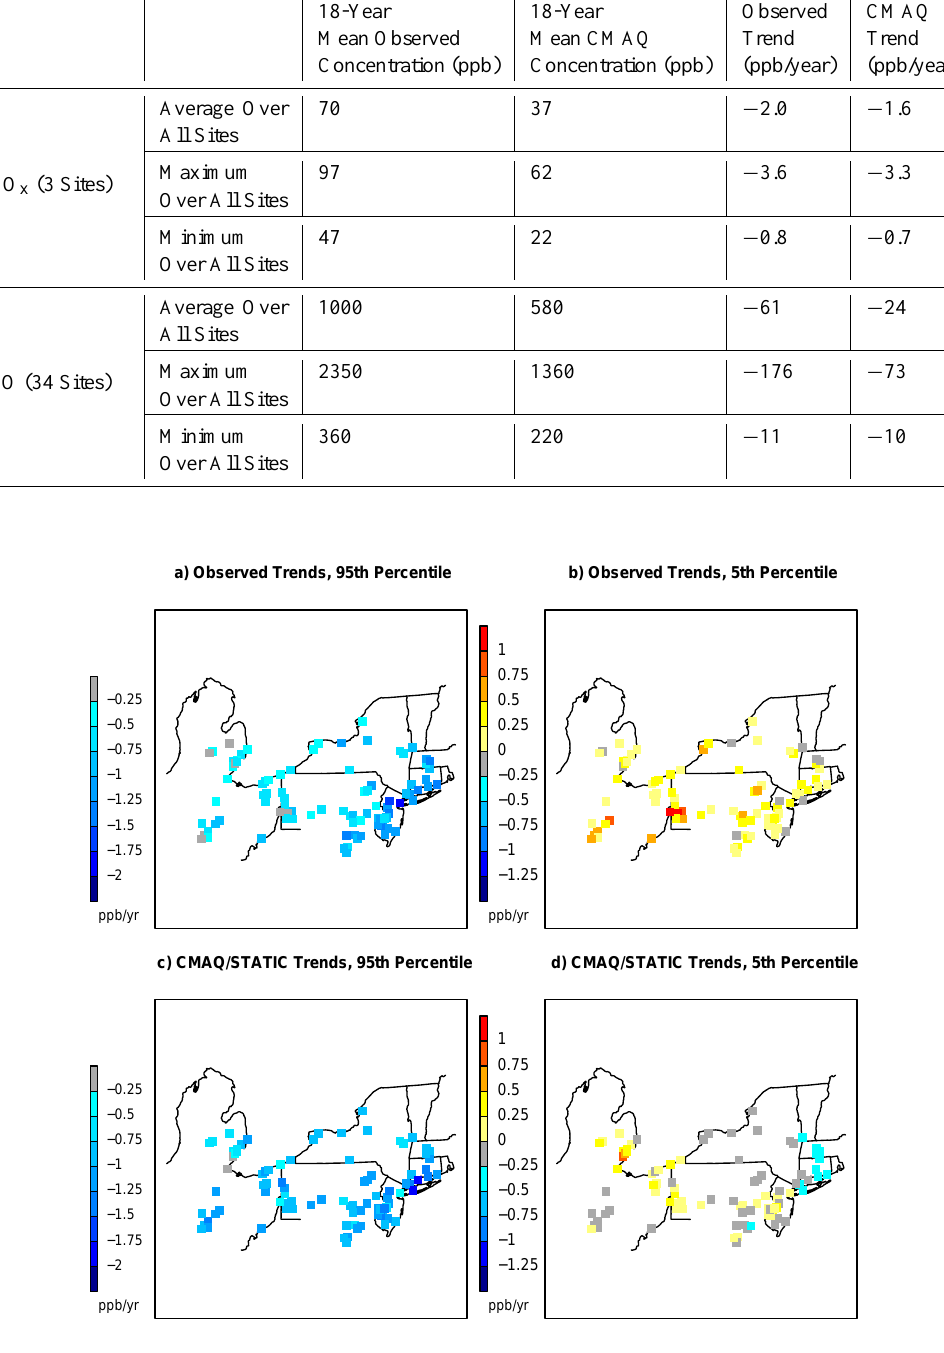
Fig. 6. Least-squares trend estimates for the 95th and 5th percentiles of May–September 8-h daily maximum ozone concentrations over the 1988–2005 time period. Results for observations are shown in the top row while results for the CMAQ/STATIC simulations are shown in the bottom